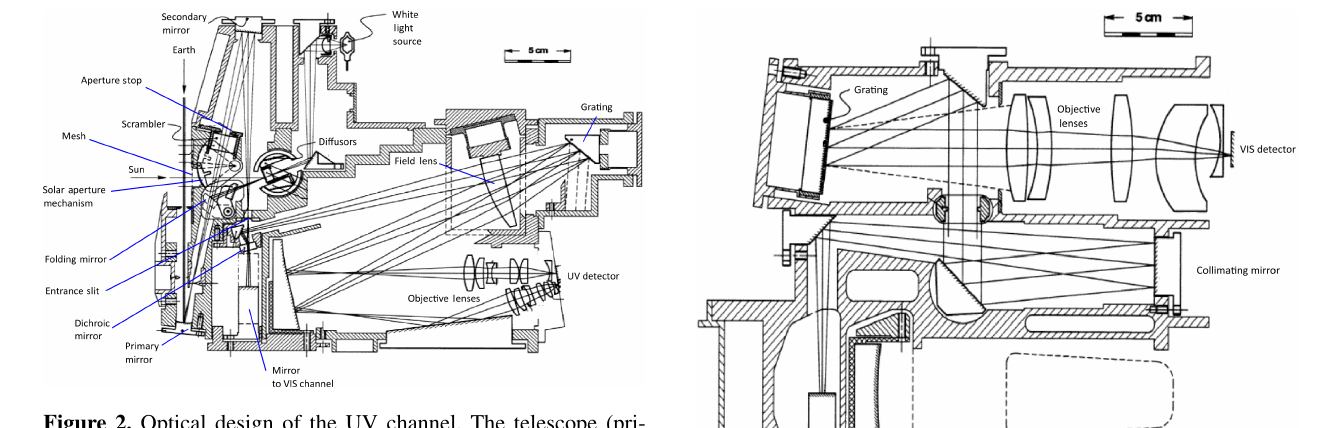
Figure 2. Optical design of the UV channel. The telescope (pri- mary and secondary mirror) is used for both channels. The visible light that passes the dichroic mirror is coupled into the VIS chan- nel. The folding mirror is depicted in two positions (Earth view and Sun/calibration view).